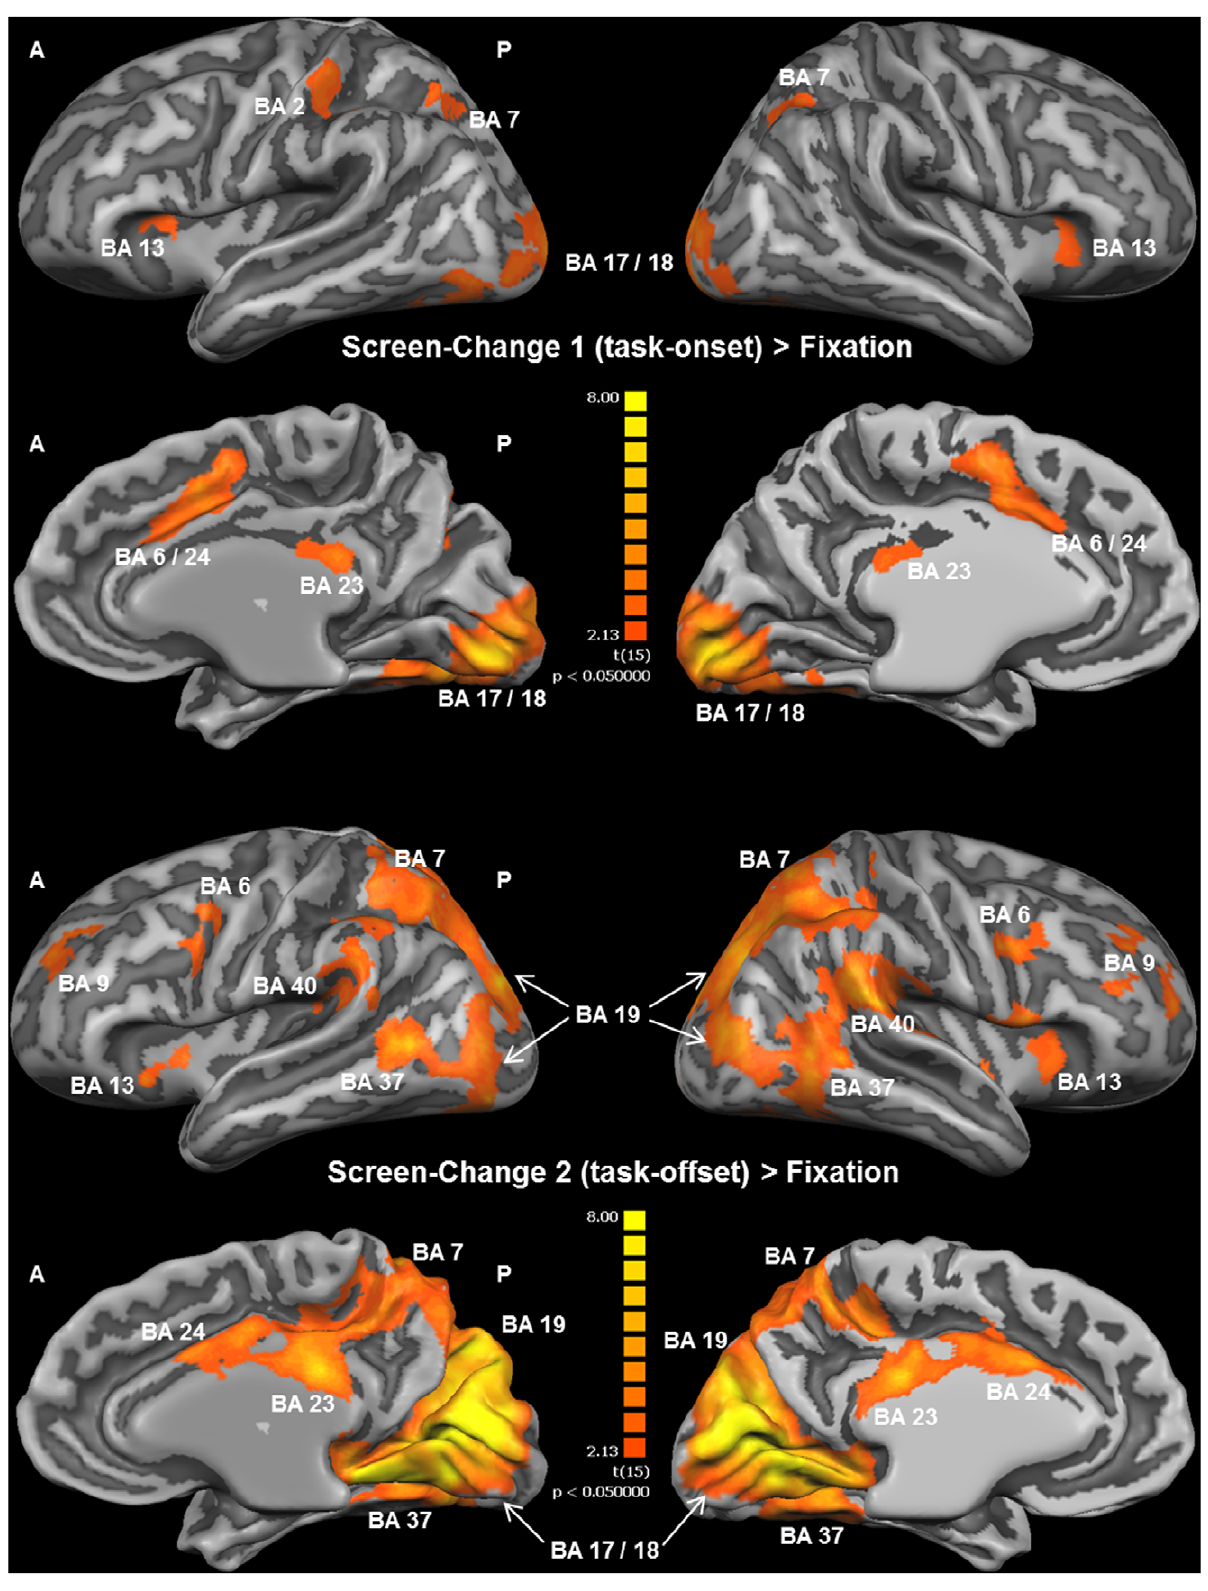
Figure 4. Whole-brain results for the block-onset and block-offset predictors (RFX-GLM; n =16). The displayed clusters of activation result from the contrast SC 1 . Fixation (=block-onset) in the upper part of the Figure, and from the contrast SC 2 . Fixation (=block-offset) in the lower part of the Figure. For visualization, results were projected onto the optimized 3D surface reconstruction which represents the average brain of